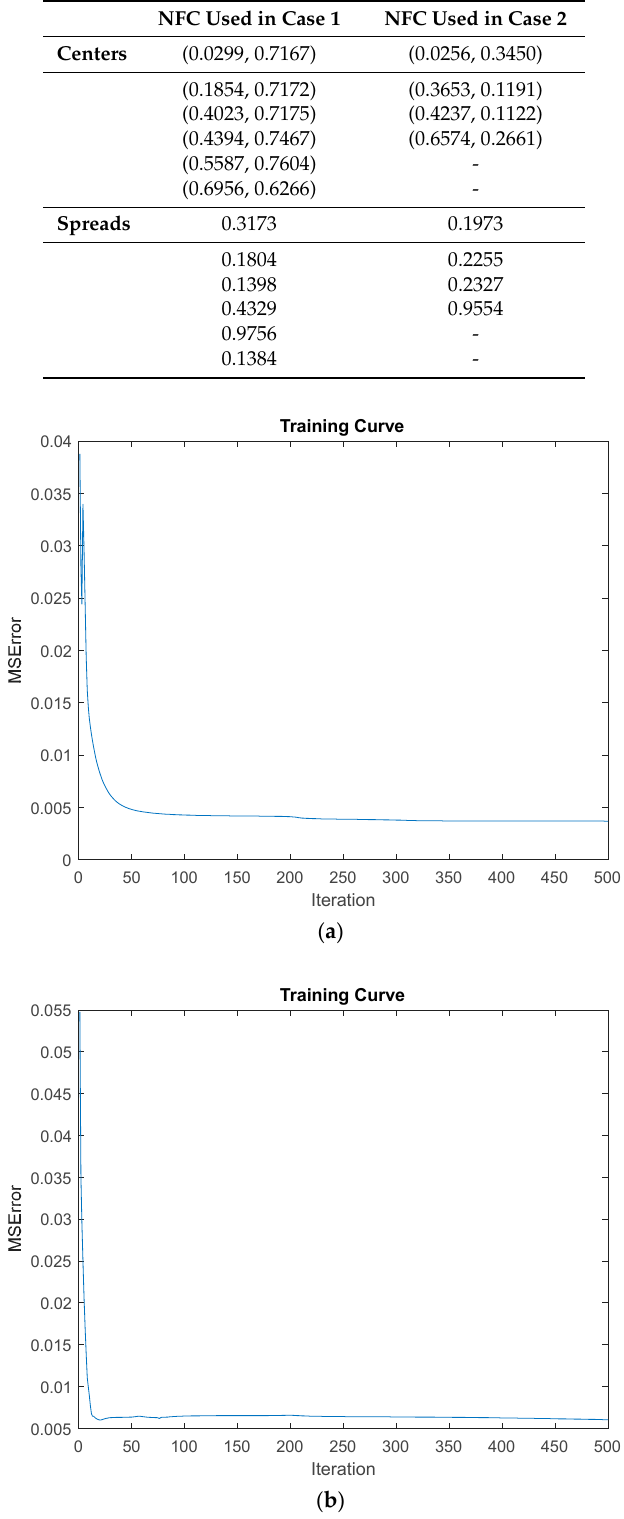
Figure 8. Training results for the ( a ) NFC used in case 1 and ( b ) NFC used in case 2. Table 4. Load classification results obtained by the novel hybrid UAC-NFC model.